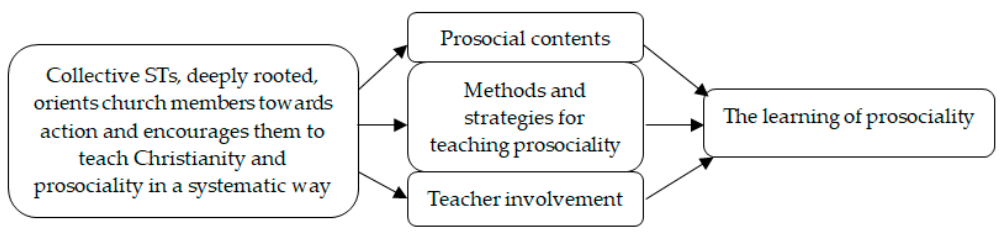
Figure 4. Axial coding: teaching and learning of prosociality.